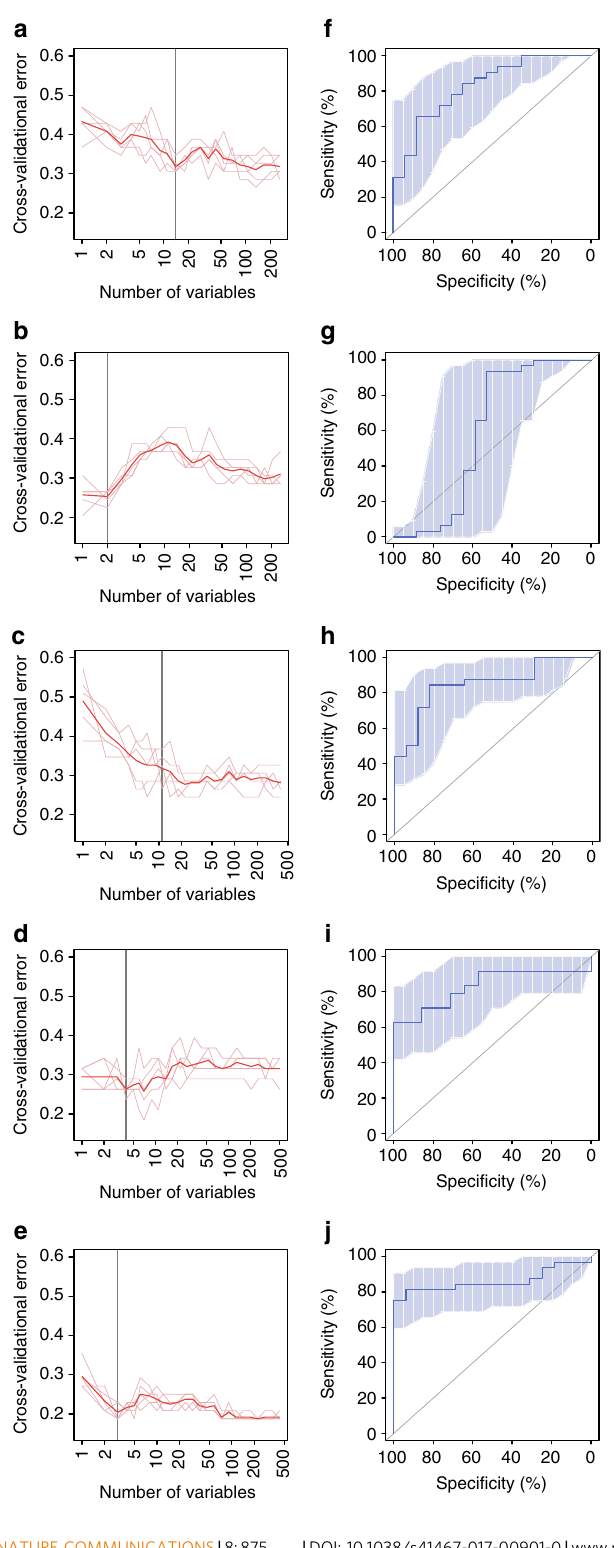
Fig. 5 Microbiota-based classi fi cation of infertility due to endometriosis. a , b , c , d , e Distribution of 5 trials of 10-fold cross-validation error in random forest classi fi cation of fertile versus infertile samples as the number of OTUs increases ( a , CL; b , CU; c , CV; d , ET; e , PF). The model was trained using relative abundance of the OTUs (present in at least 10% of the samples) in the samples ( n = 16 without endometriosis (fertile), 32 with endometriosis (infertile)). Subjects with endometriosis who had given birth, and infertile subjects due to reasons other than endometriosis, e.g. salpingemphraxis, were not analysed (Supplementary Data 1). The red curve indicates an average of the fi ve trials (pink lines). The grey line marks the number of OTUs in the optimal set. ( f , g , h , i , j ) Receiver operating curve (ROC) for the cross-validated sample set ( f , CL; g , CU; h , CV; i , ET; j , PF). The area under receiver operating curve ( AUC ) is 0.8272, 0.5919, 0.8493, 0.8304 and 0.8613, respectively. The 95% con fi dence intervals (CI) are shown as shaded areas. The diagonal lines mark an AUC of 0.5 (i.e. random classi fi